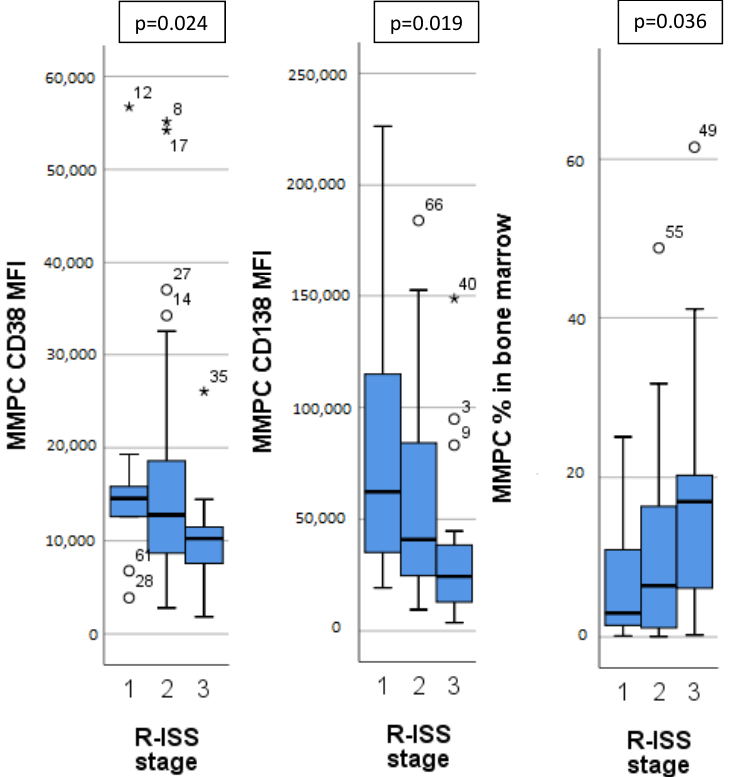
Figure 2. Significant differences in immunophenotype between different Revised—International Staging System (R-ISS) for multiple myeloma. MMPC—malignant plasma cells. MFI—mean fluorescence intensity. Outliers marked with *.